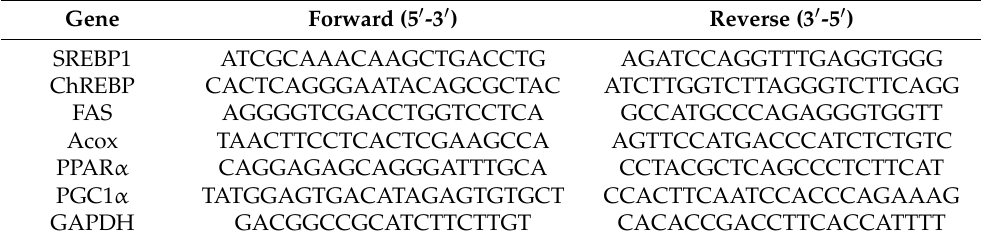
Table 3. Real-time polymerase chain reaction (PCR) primer sequences.